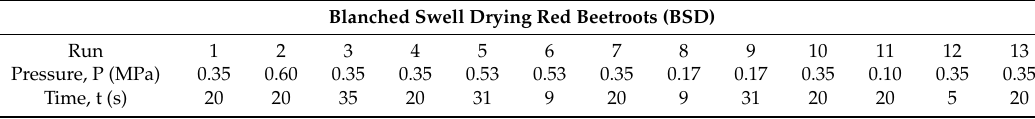
Table 3. The experimental design for BSD red beetroots.